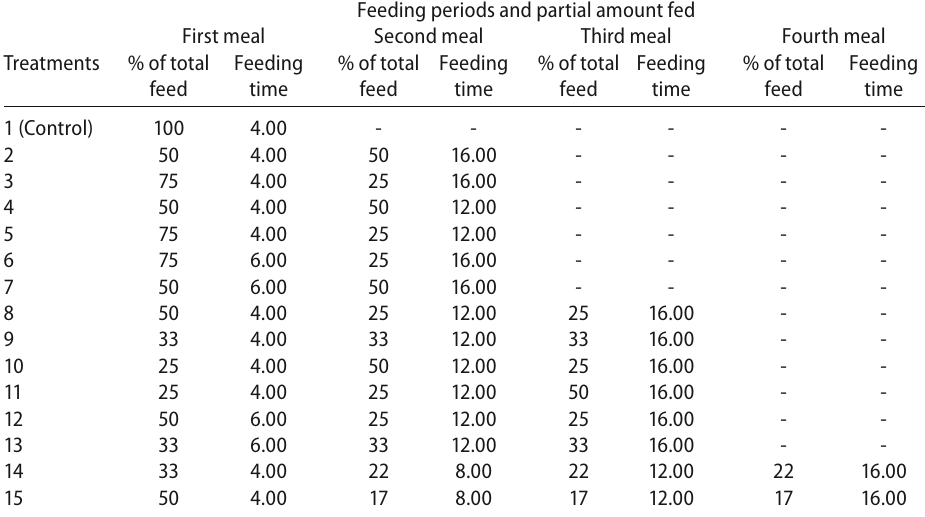
Timetable and amount of feed in each treatment